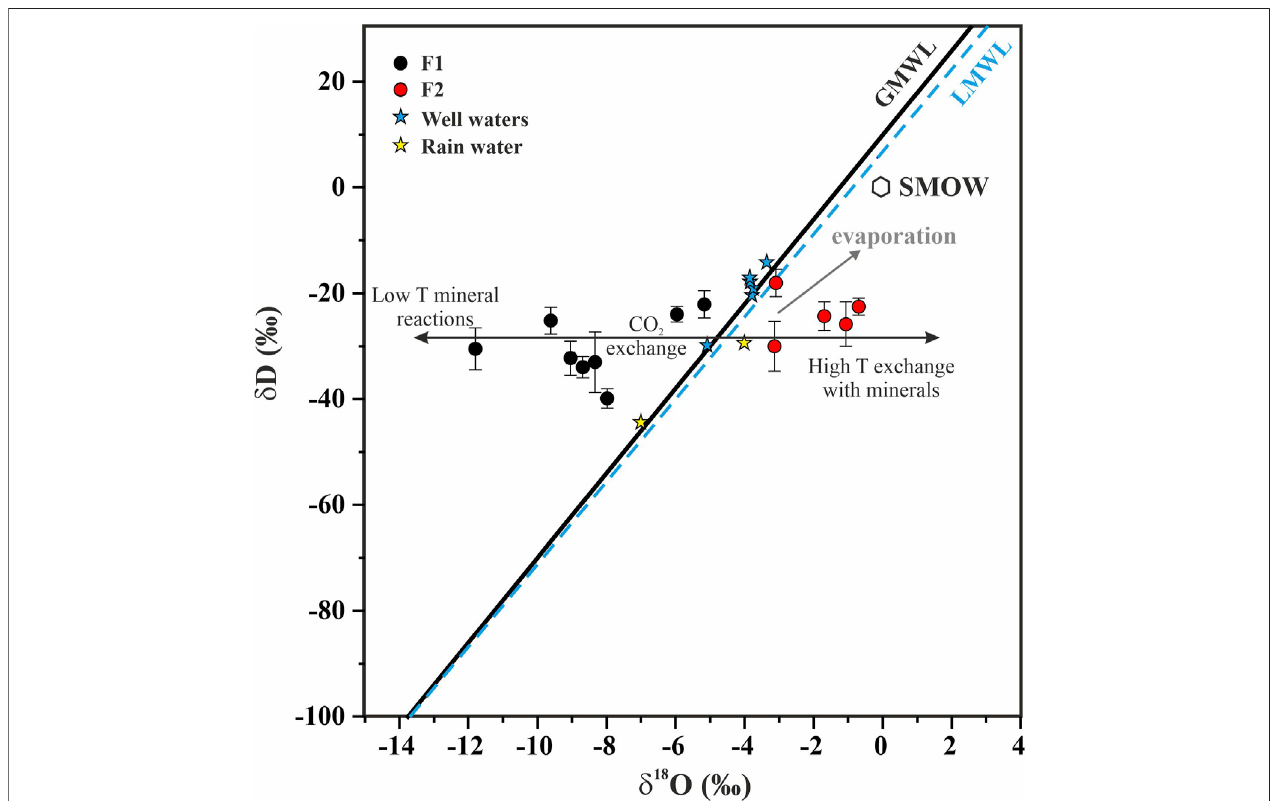
FIGURE 6 | δ 2 H -H 2 O vs. δ 18 O-H 2 O for condensates collected in F1 and F2 fumaroles at Pico do Fogo volcano. The Global Meteoric Water Line (GMWL; Craig, 1961)andtheLocalMeteoricWaterLine(LMWL;Sacchietal.,1995)areshown.Blueandyellowstarscorrespondtogroundwaterscollectedfromwells,andrainwater, respectively (Mosteiros Basin, Fogo Island; Heilweil et al., 2009). Black arrows adapted from D ’ Amore and Panichi (1987).